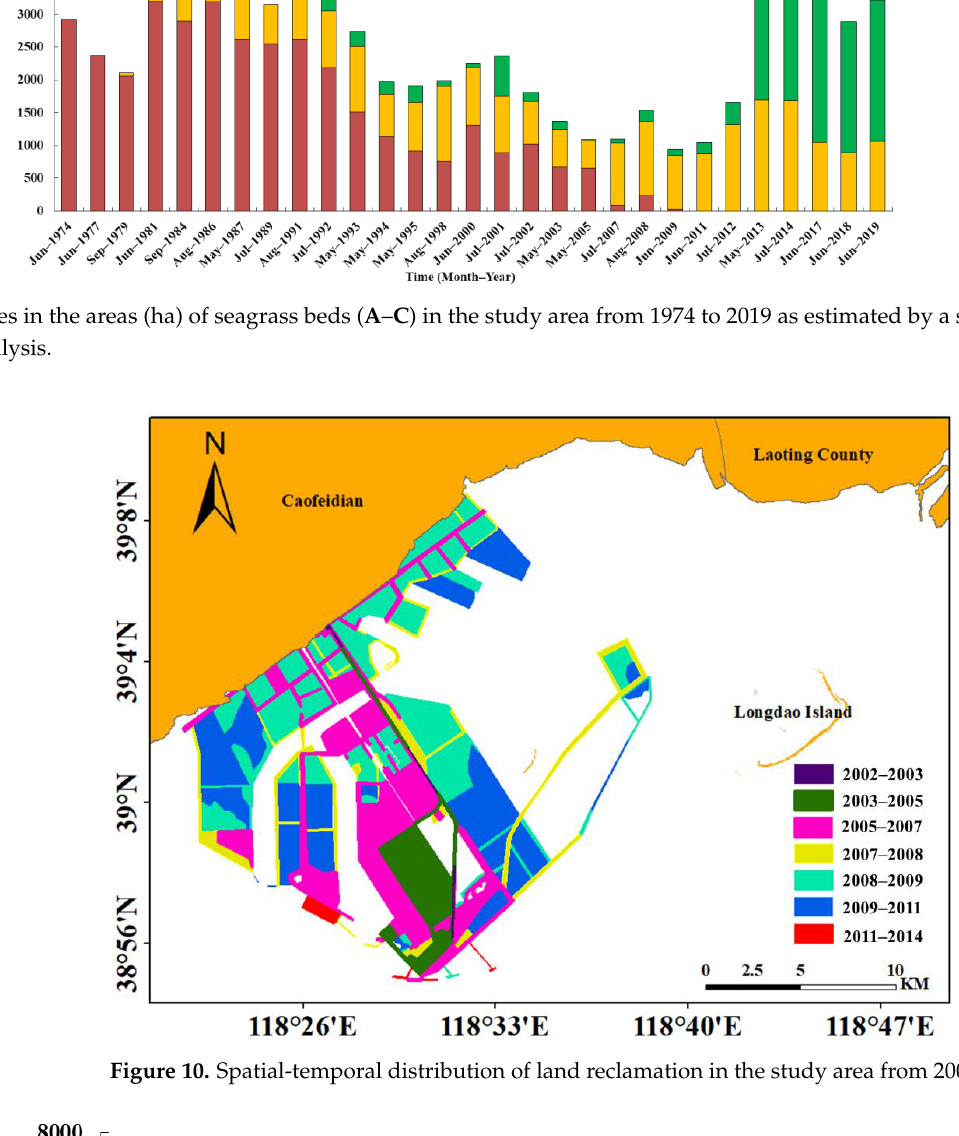
Figure 9. Changes in the areas (ha) of seagrass beds ( A – C ) in the study area from 1974 to 2019 as estimated by a satellite- image-based analysis.